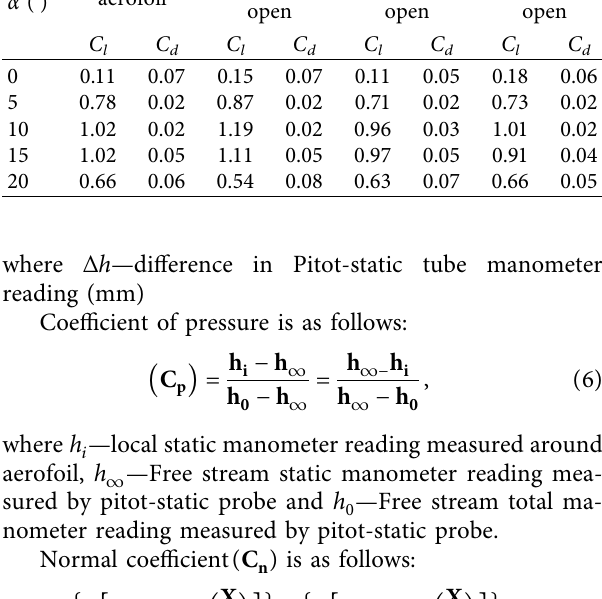
l and angle of attack.